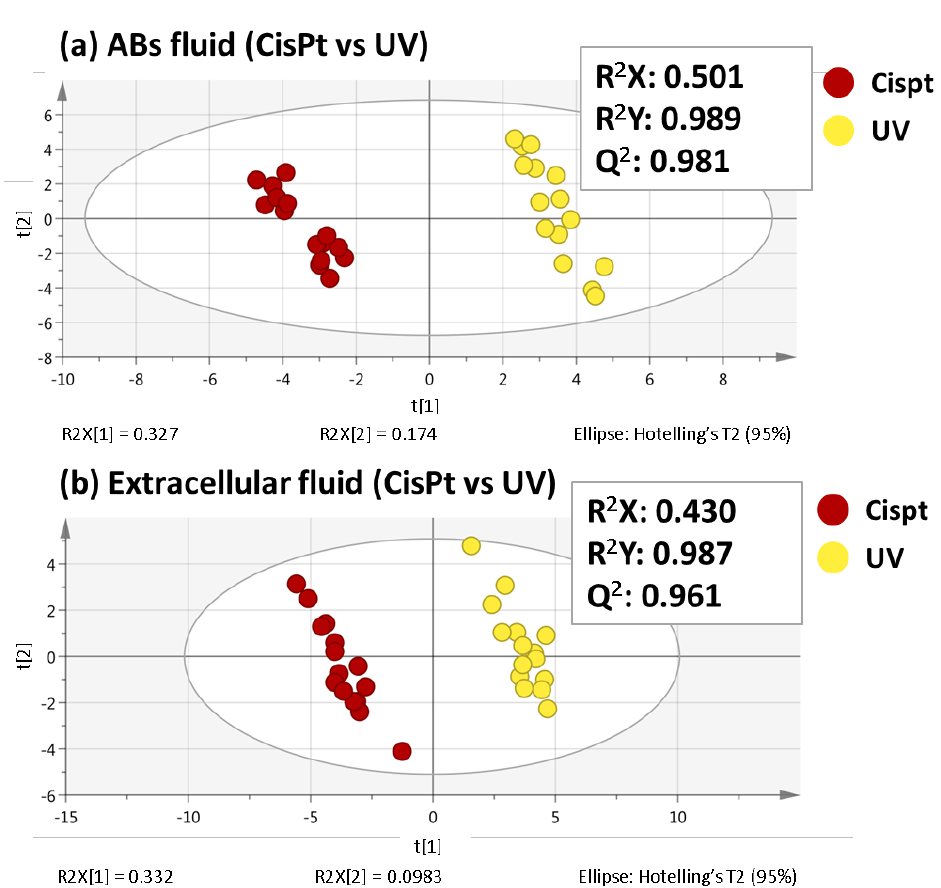
Figure 2. PLS-DA score plots (Cispt vs. UV) for both ABs fluid ( a ) and extracellular fluid ( b ) analyses. To ensure that the separation showed by PLS-DA was not achieved purely by chance, a permutation test using 200 permutations was performed, obtaining positive slopes for both ABs fluid and extracellular fluid (Figure 3), which emphasizes the veracity of the PLS-DA models [15]. Finally, a variable importance in the projection (VIP) value higher than 1.10 was used to select those variables that changed significantly between ABs induced by cisplatin and ABs induced by